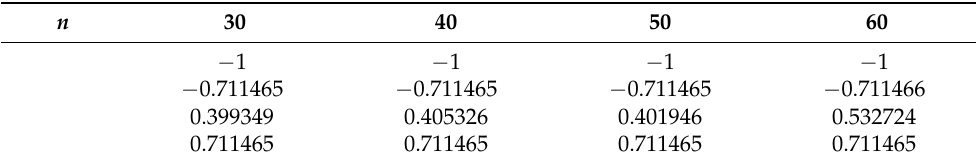
Table 2. Approximate real zeros of C S n ,0.9,0.1 ( x ,2 )